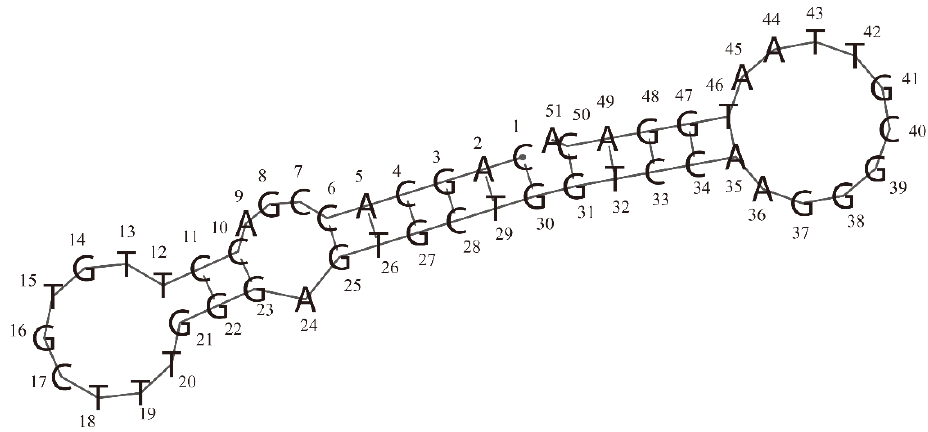
Figure 9. Secondary structure of the RBD-1C aptamer was predicted by the RNAfold web server [45]. In this structure, 2 hairpins (at two ends) and 1 internal loop can be observed.